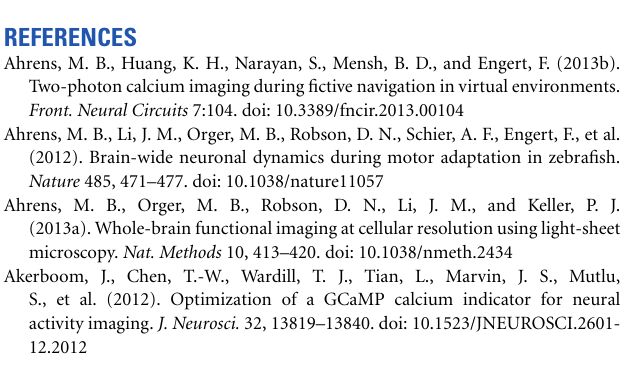
Figure S5 | Related to Figure 5. (A) Correlation matrix of LD0 ∼ LD1 for the simulation with Algorithm IV [Efficiency] is very similar to the matrix from real fish ( Figure 3E first panel). (B) The average “efficiency” compared between real fish and different simulations, augmenting Figure 5E . Since Algorithm IV [Efficiency] depends on the “flip” of LD0 ∼ LD1, Algorithm II [Lock/Flip] is not permutated separately from Algorithm IV. The brown bar suggests that even though Algorithm III [Bounce] is not sufficient to enhance the “efficiency” alone, it still contributes significantly in the presence of Algorithm IV. (C) Similar to Figure 5F but for DL0 (last turn in dark) vs. DL1 (first turn in light). No significant change is seen in the real fish (black curve), and matching the black curve better (red curve) does not have significant effects on the simulation. (D–F) Data analyzed for only the first 2min from all VC sessions. [For first 2min of each session, P(within 3 bouts) = 0.96 ± 0.01, mean ± s.e.m, not shown in figure]. (D) Turning angle distributions in light (left) and dark (right); compare to Figure 2B . (E) Correlation matrix of cumulative angles; compare to Figure 4C . (F) Histogram of the per-fish “efficiency” (0.72 ± 0.02, mean ± s.e.m), compare to Figure 5B